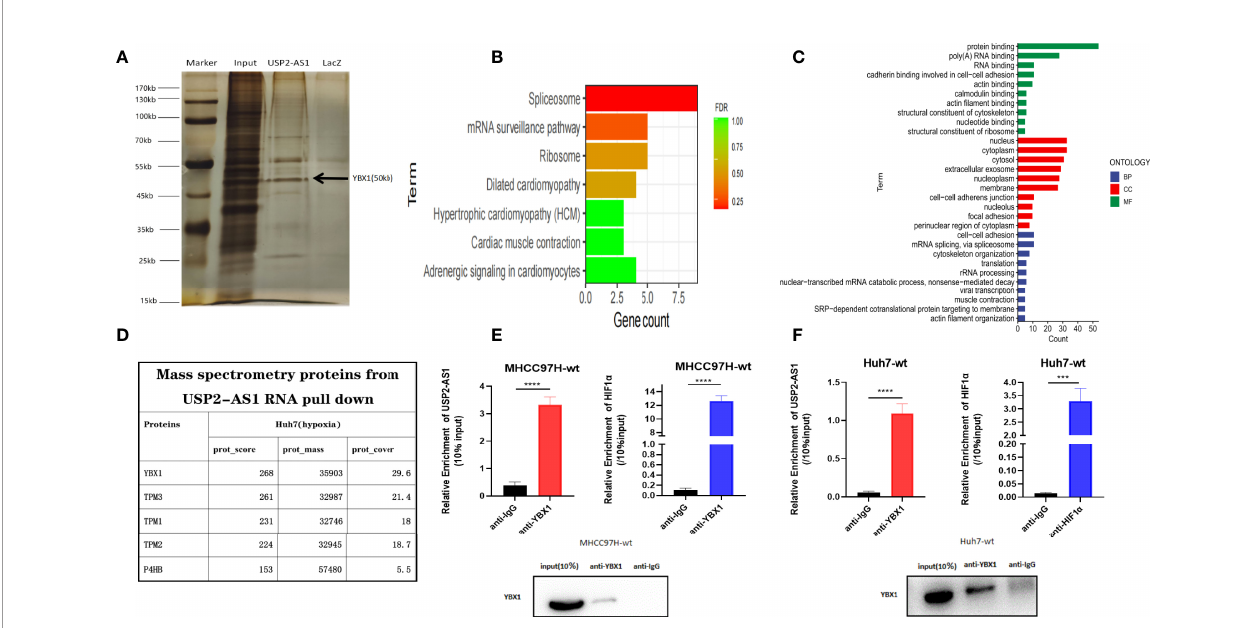
FIGURE 3 | USP2-AS1 physically interacts with YBX1 under hypoxia. (A) Silver staining and mass spectrometry analysis following RNA pull-down of USP2-AS1 or Laz (as negative control probe) in Huh7 cells after exposed to hypoxia for 48 hours. (B) KEGG pathway enrichment analysis for differential protein molecules from mass spectrometry analysis. (C) GO enrichment analysis for differential protein molecules from mass spectrometry analysis. (D) The top 5 differential proteins from mass spectrometry analysis. (E) YBX1 associated HIF1 a and USP2-AS1 as measured by qRT-PCR following RIP YBX1 in MHCC97H cells. (F) YBX1 associated HIF1 a and USP2-AS1 as measured by qRT- PCR following RIP YBX1 in Huh7 cells after being treated with hypoxia for 48 hours. ***p < 0.001, ****p < 0.0001.